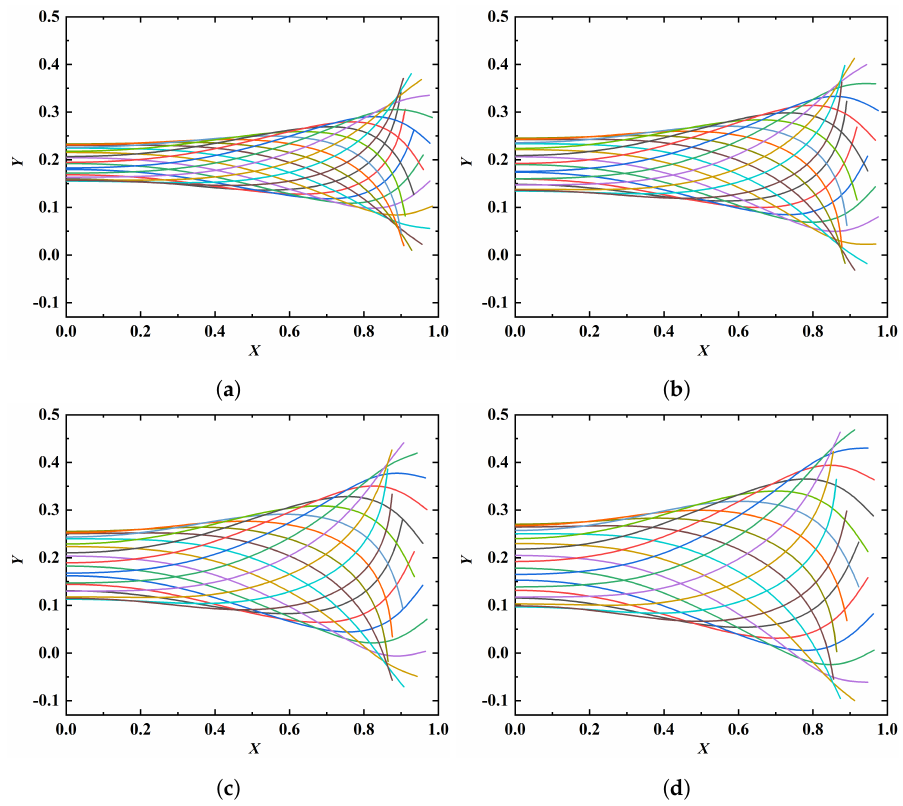
Figure 10. Amplitude envelopes at different values of A : ( a ) 150, ( b ) 200, ( c ) 250, ( d ) 300. The fixed parameters are: k = 4 π , Re =